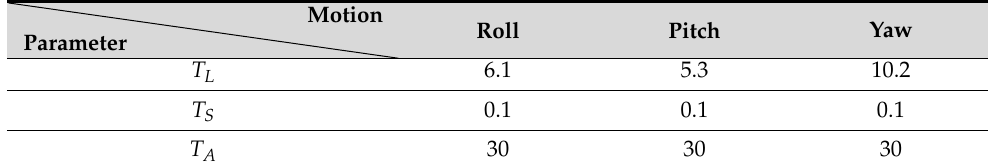
Table 3. Parameters of the vestibular